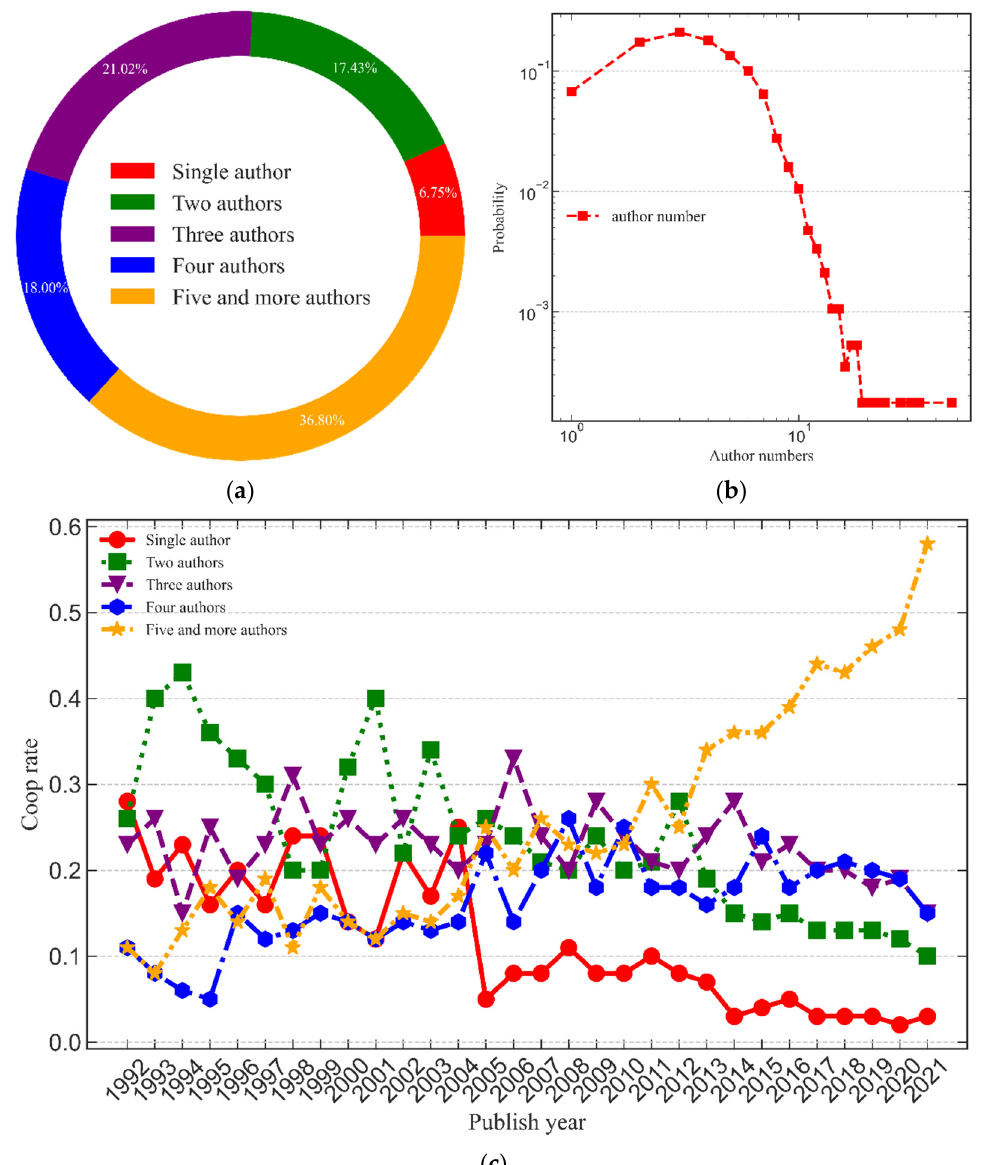
Figure 6. The author cooperation models in oil and gas wells. ( a , b ) The publication percentage and probability distribution produced by different author teams. ( c ) Annual percentage changes in publications produced by different author teams.